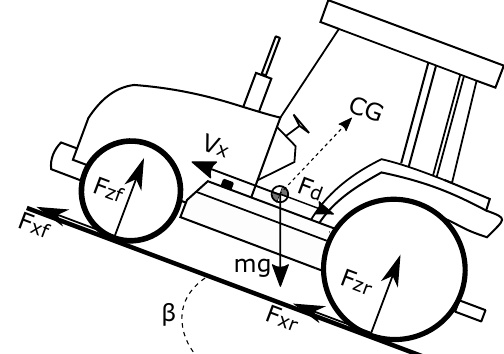
Figure 3. 1D longitudinal tractor